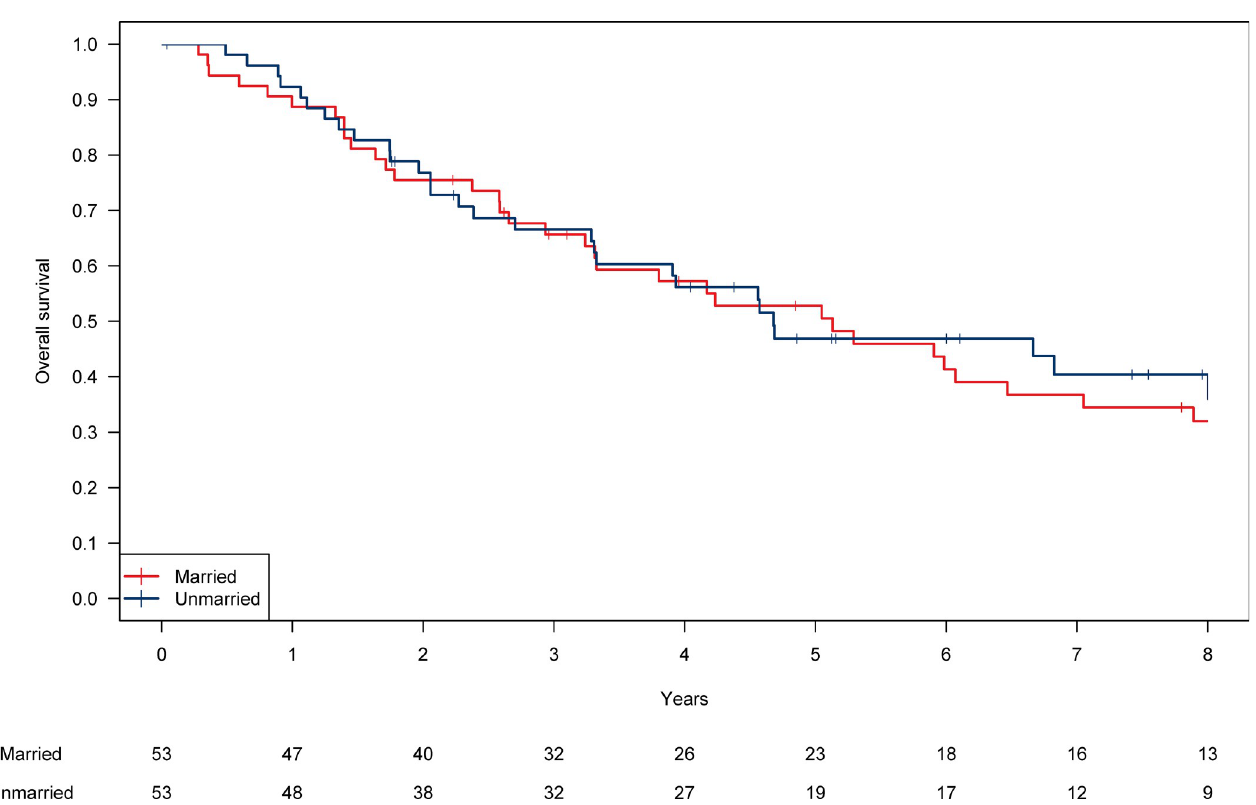
Fig 3. Kaplan-Meier curves for overall survival in the married and unmarried patients for the matched cohort.